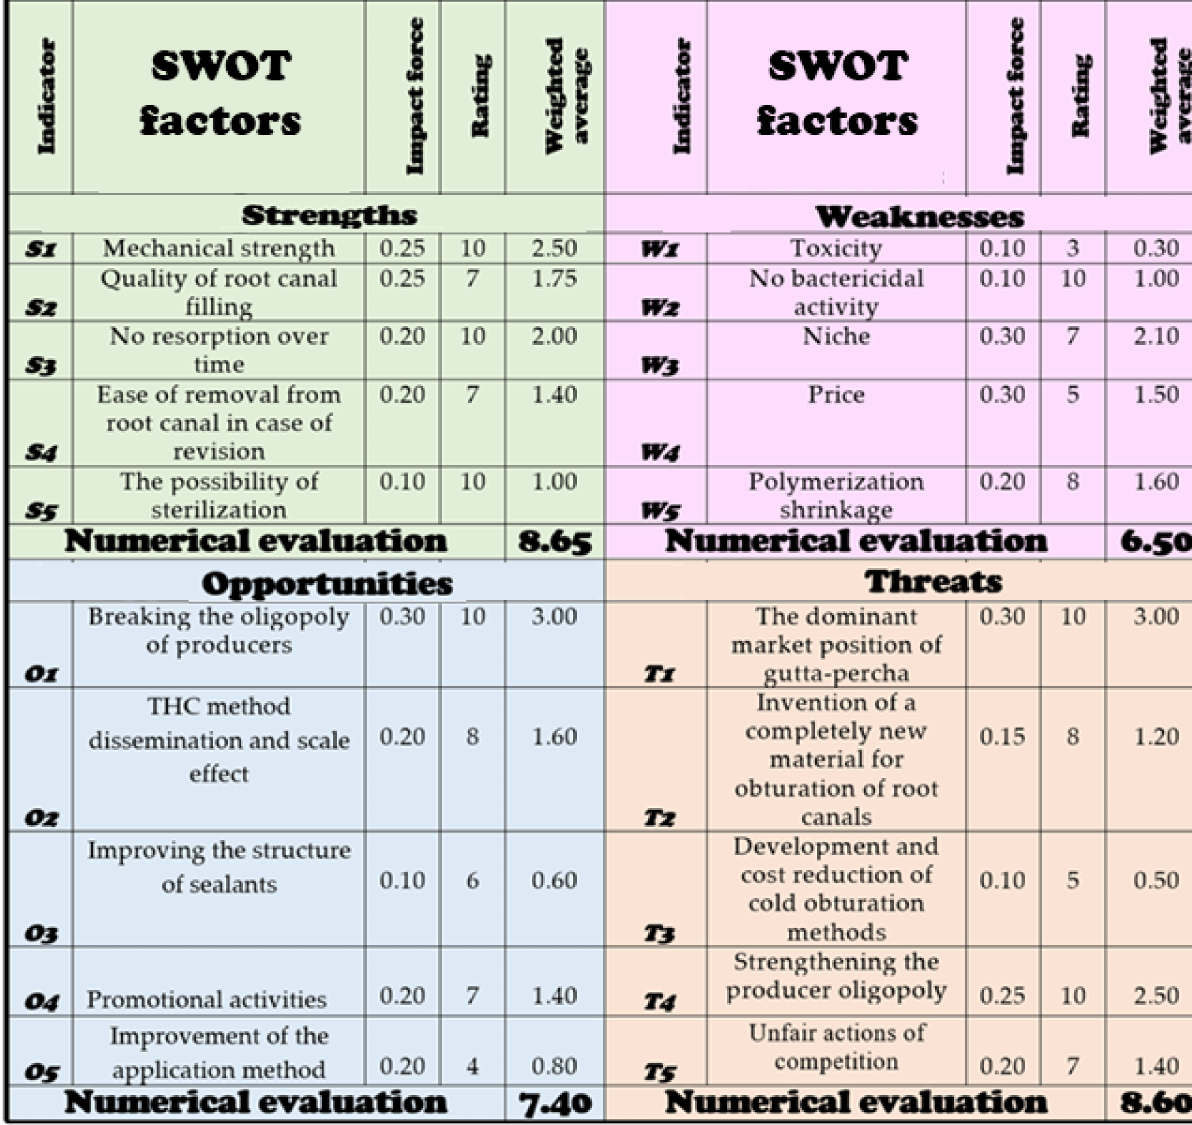
Figure 28. Criteria and results of the SWOT (strengths, weaknesses, opportunities, threats) point analysis concerning resilon as a filling material used for filling root canals in